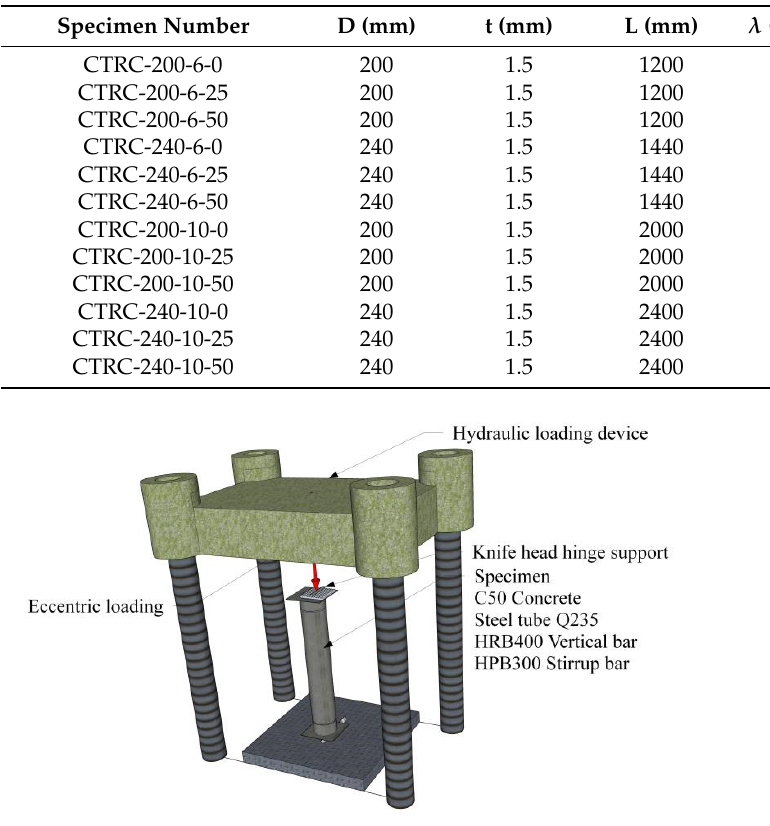
Table 3. Specimen configuration [20].